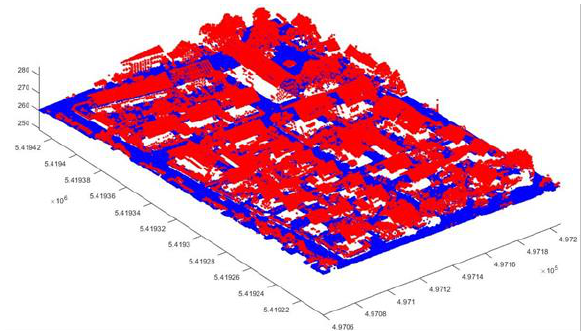
Figure 3. Result of filtering, blue (ground points) and red (above ground points such as: tree, building, car, …)